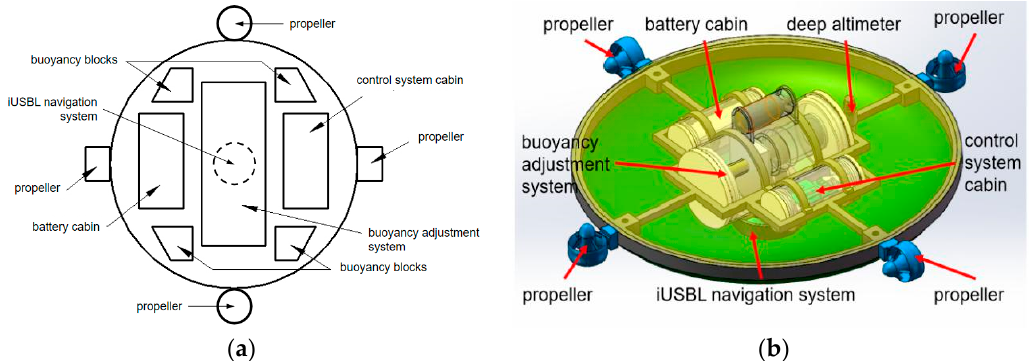
Figure 6. General layout of the prototype: ( a ) Top view layout concept diagram; ( b ) 3D model diagram.